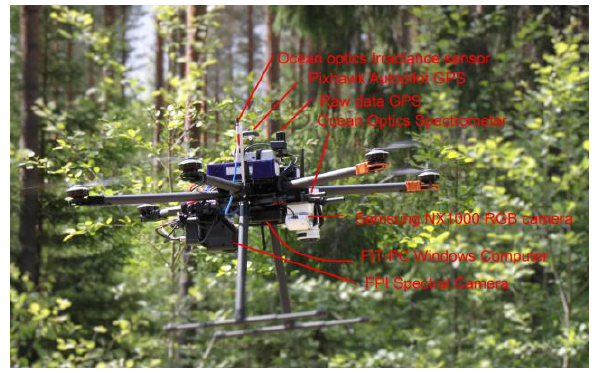
Figure 1. UAV imaging